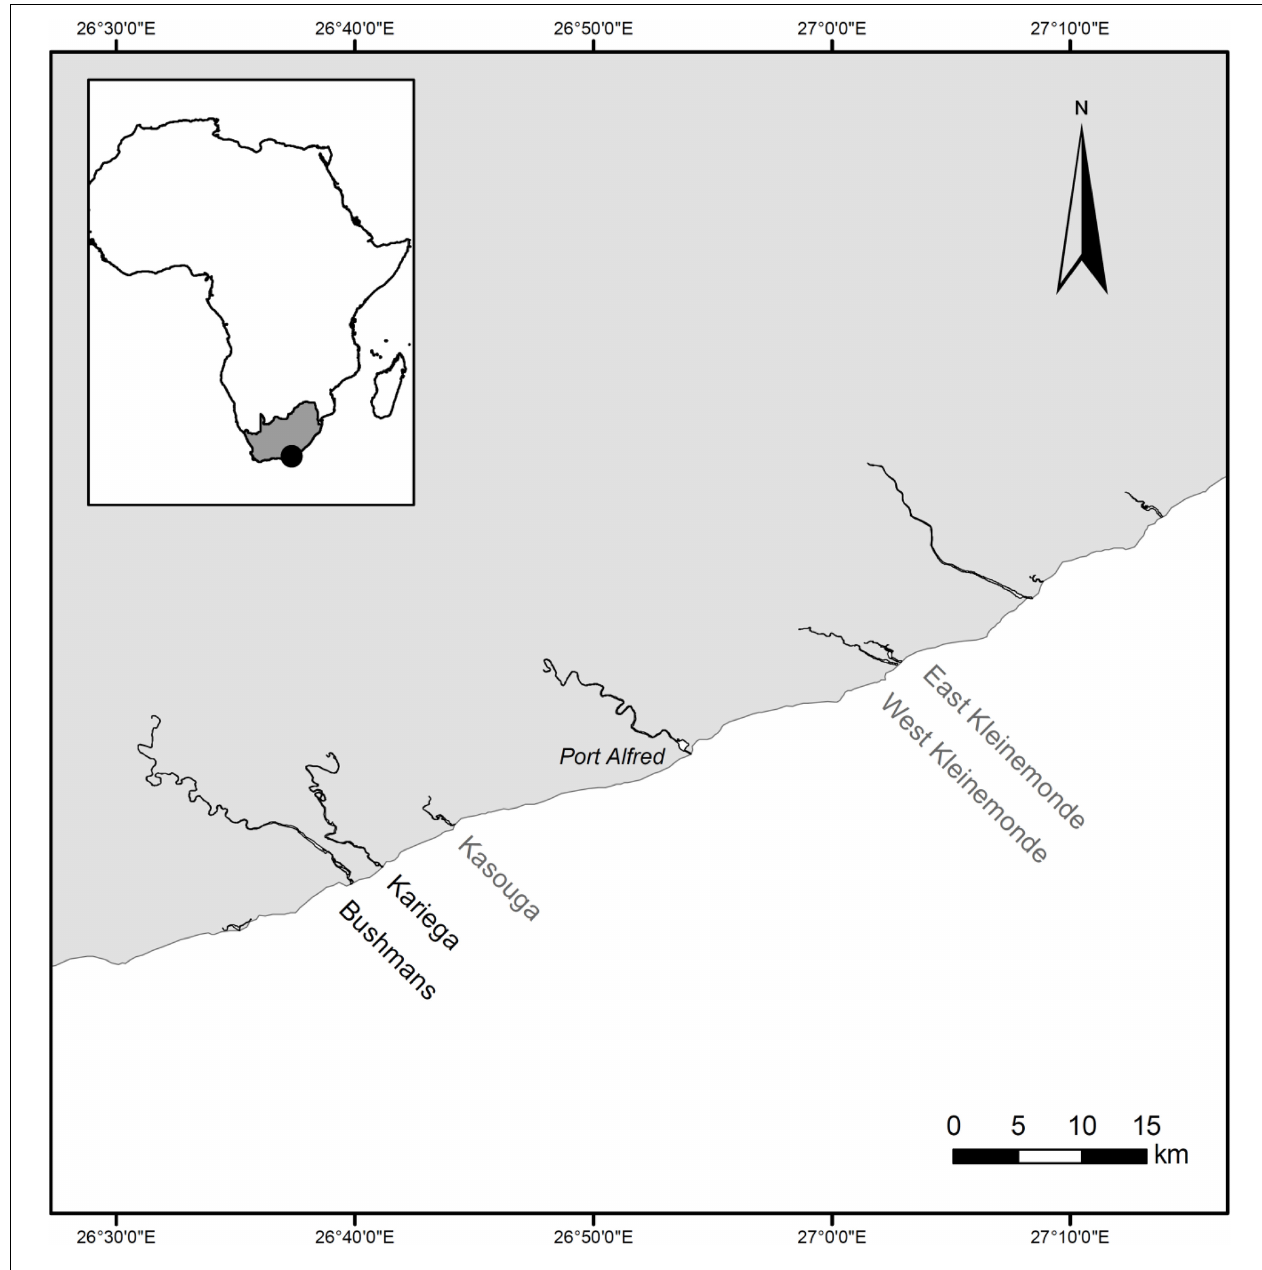
FIGURE 1 | Present and past distribution of the estuarine pipefish, Syngnathus watermeyeri , on the eastern south coast of South Africa. The species is currently found in the two estuaries labelled in black; populations in the estuaries with grey labels are believed to be extinct. The estuarine pipefish has never been reported from any of the other estuaries shown on this